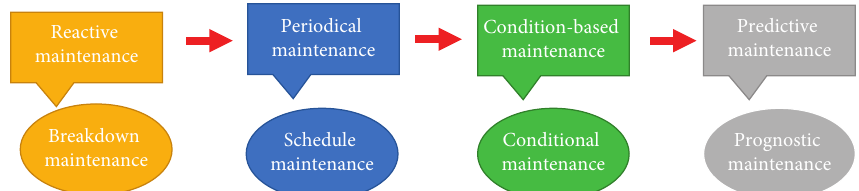
Figure 1: Four types of maintenance of mechanical components.